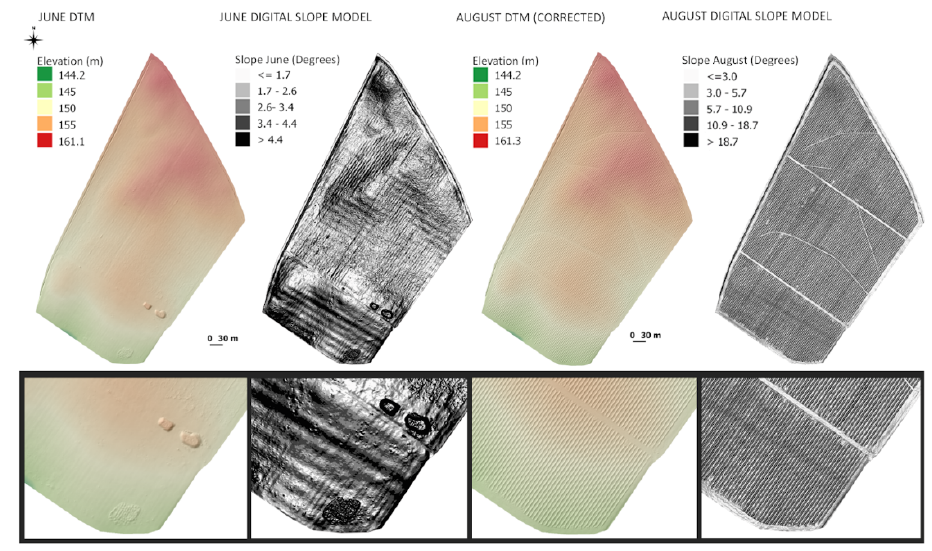
Figure 15. DTM and digital slope model of the area of interest in June and August. For the representation of slopes, a quantile classification was used.